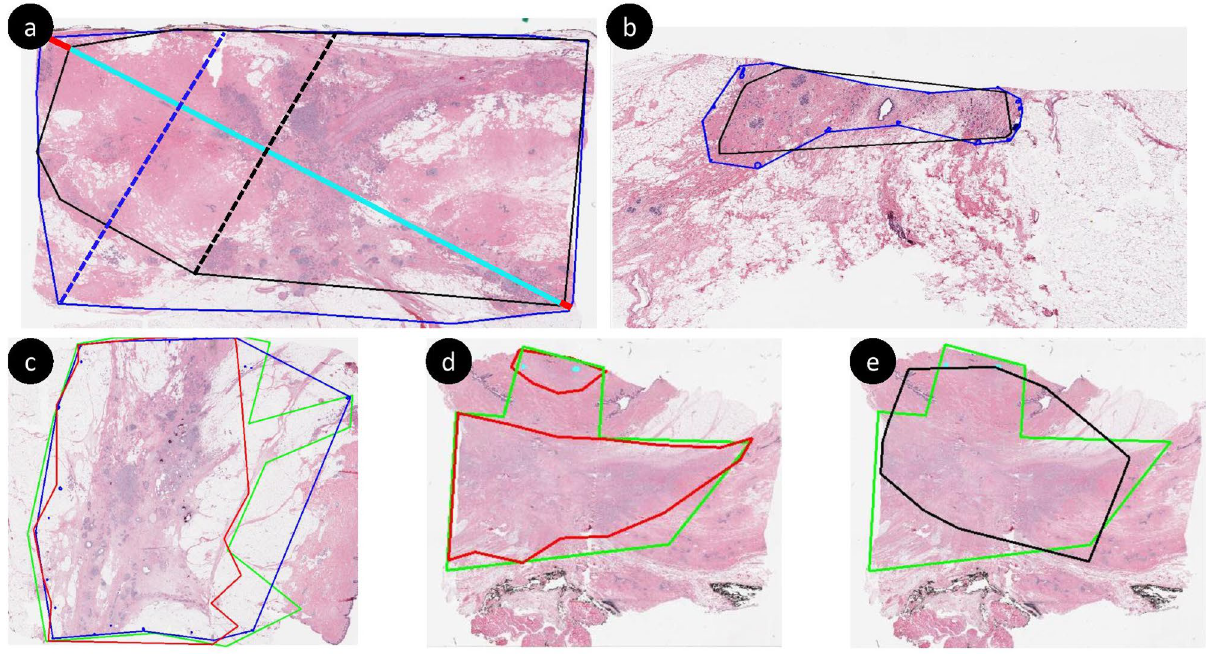
Figure 3. Comparison between Dice and d prim . Each annotation is converted to its convex hull to extract d prim between the compared masks. To avoid crowding, we only show the tumor bed extents for ( a ), where the longest diagonal difference (shown in red lines) is ∼ 1 mm, whereas the perpendicular diagonal difference is ∼ 2